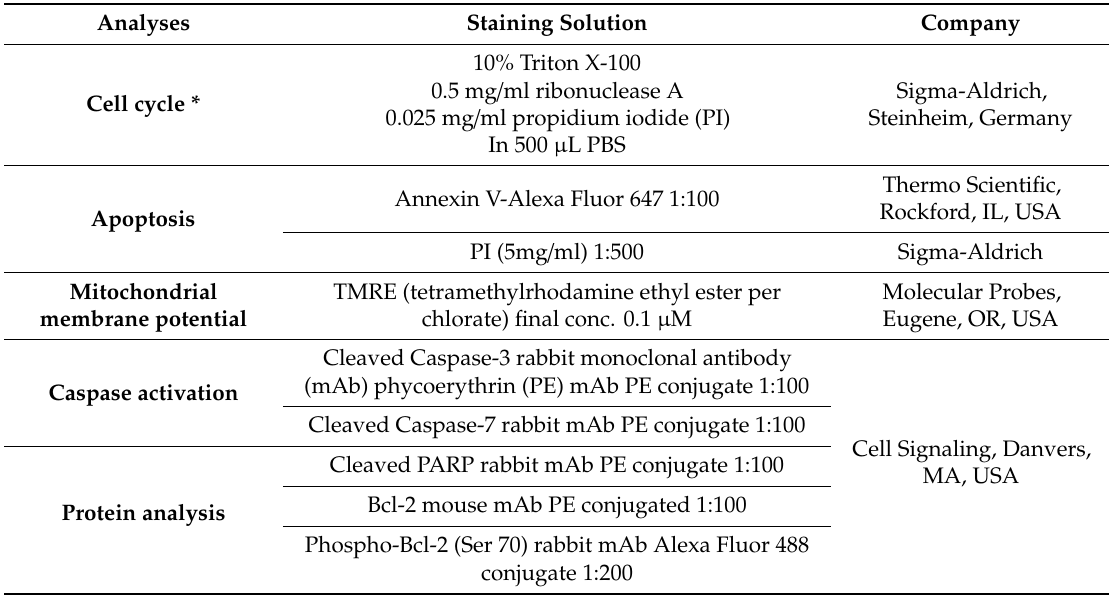
Table 8. Staining solutions used within in vitro